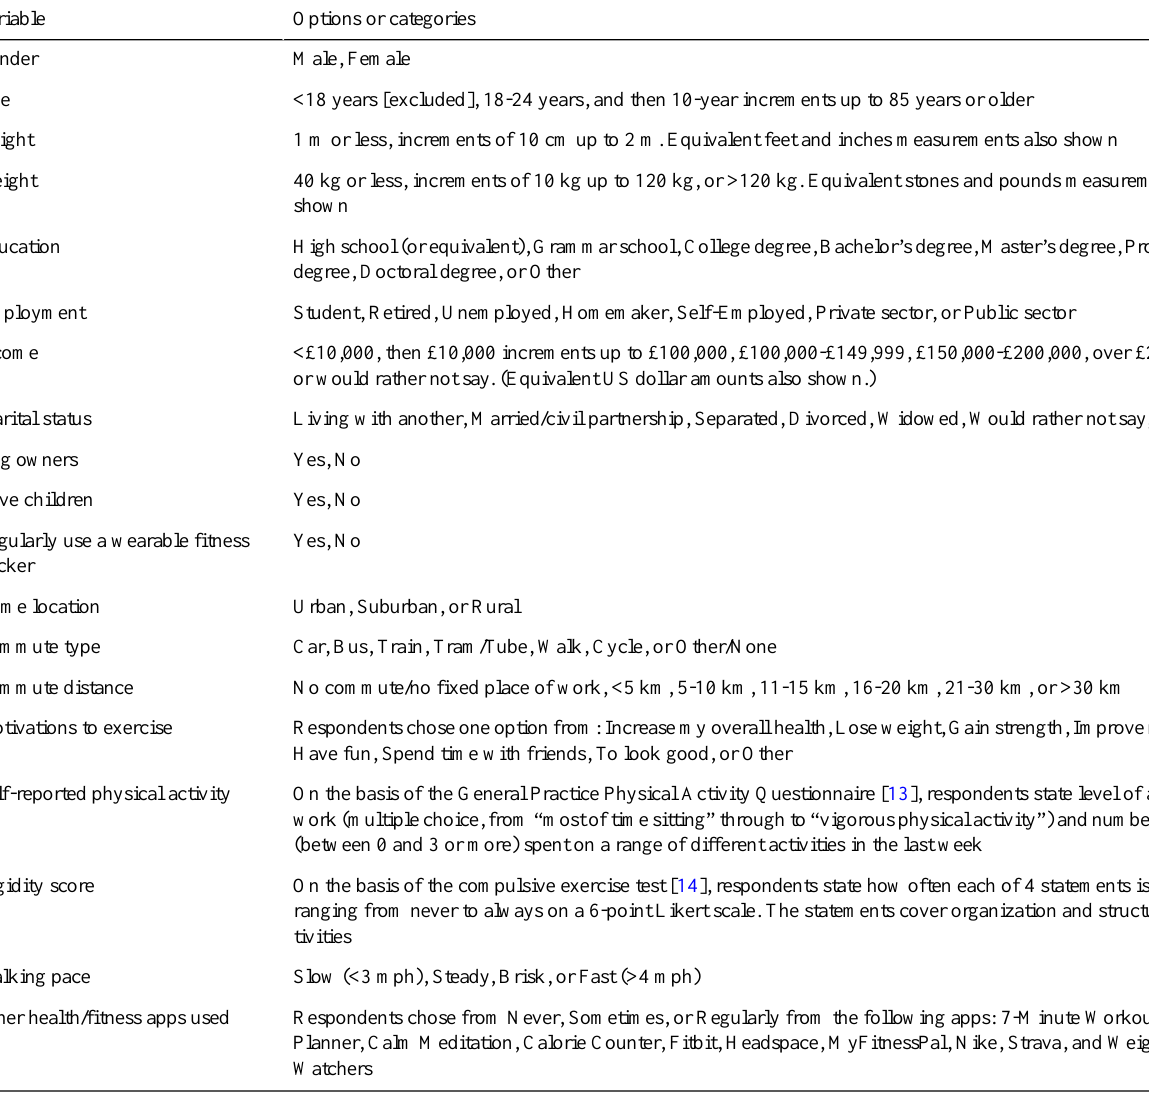
Table 1. Demographic and other variables included in the questionnaire, along with options or categories. Options or